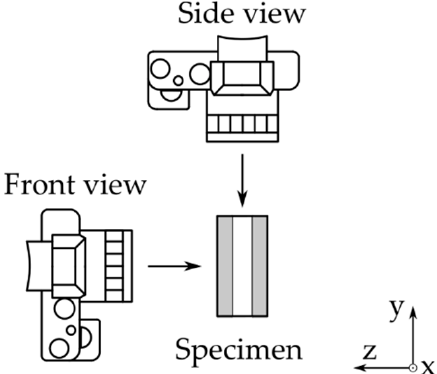
Figure 1. DIC camera setup seen from the top side.